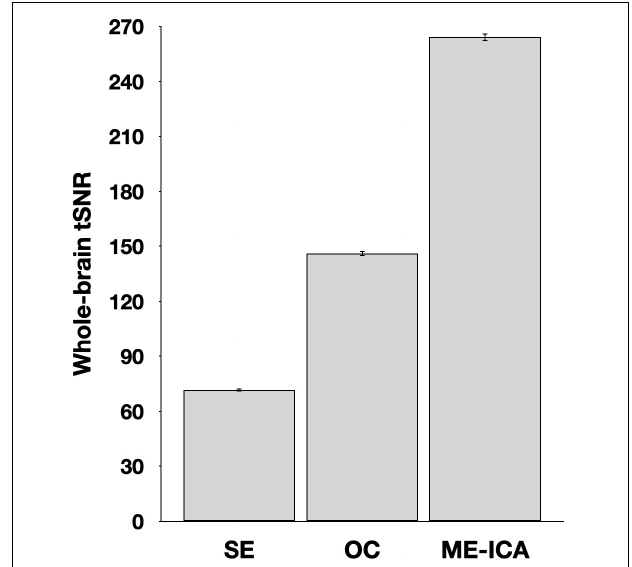
FIGURE 1 | Whole brain temporal signal-to-noise (tSNR) estimates following various stages of processing. Values reflect the timeseries mean divided by its standard deviation prior to smoothing, rescaling, or detrending. Error bars reflect standard error of the mean. SE, single-echo; OC, optimally combined; ME-ICA, multi-echo independent components